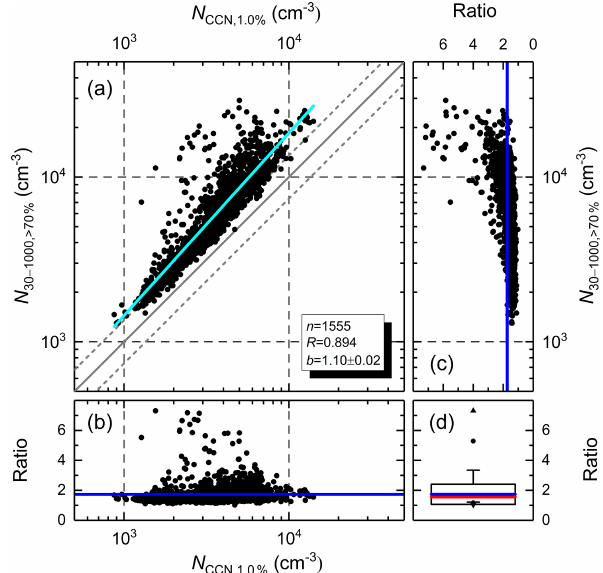
Figure 1. Relationship between the concentration of particles with diameters > 30nm that contribute > 70% of all particles ( N 30–1000 ,> 70% ) and the CCN concentration at a supersaturation of 1.0% ( N CCN , 1 . 0% ) (a) ; the number of the data points con- sidered ( n ), their coefficient of correlation ( R ) and the slope ( b ) and SD of the regression line (in cyan) are also indicated. The line of equality and the dashed grey lines indicate the range of uncertainty expected solely from particle counting ( ± 15%). The N 30–1000 ,> 70% /N CCN , 1 . 0% ratio is also shown as functions of the variables N CCN , 1 . 0% (b) and N 30–1000 ,> 70% (c) , with the mean indicated by the blue line in each plot. The box and whisker plot (d) summarises the maximum and minimum (triangles point- ing upward and downward, respectively), the first and 99th per- centiles (bullets), the mean and SD (blue line and the horizontal borders of the box, respectively), and the median (red line) of the N 30–1000 ,> 70% /N CCN , 1 . 0%